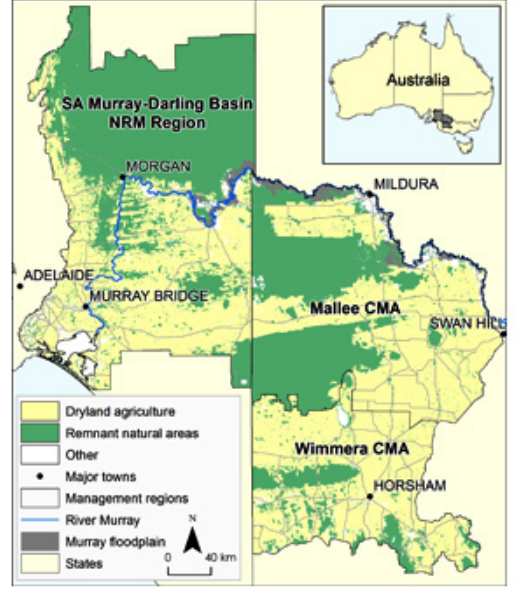
Fig. 1 . Location and land use in the Lower Murray study